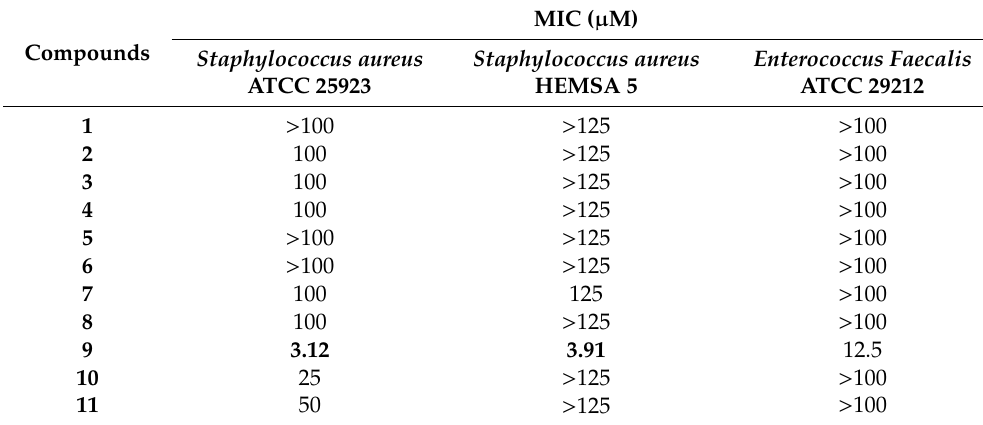
Table 2. Minimum inhibitory concentration (MICs) of the selenocompounds on the Gram-positive bacteria. In bold—MIC values < 10 µ